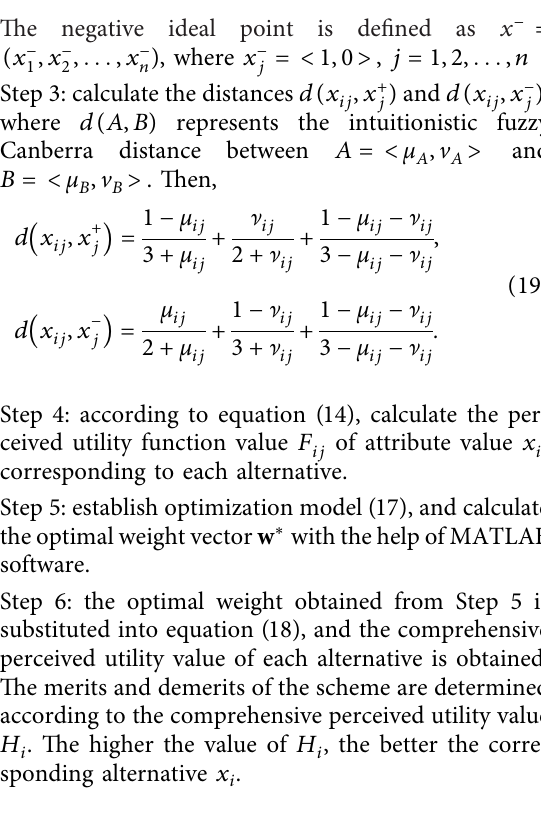
Figure 2: The calculation process of the intuitionistic fuzzy MADM